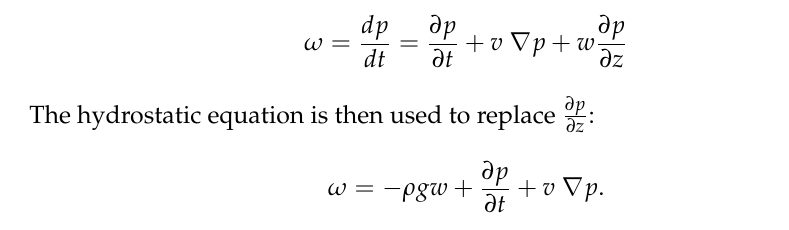
Figure 2. A map presenting the domains selected for the implementation of the WRF model. The yellow boxes indicate the domains used in the WRF model.